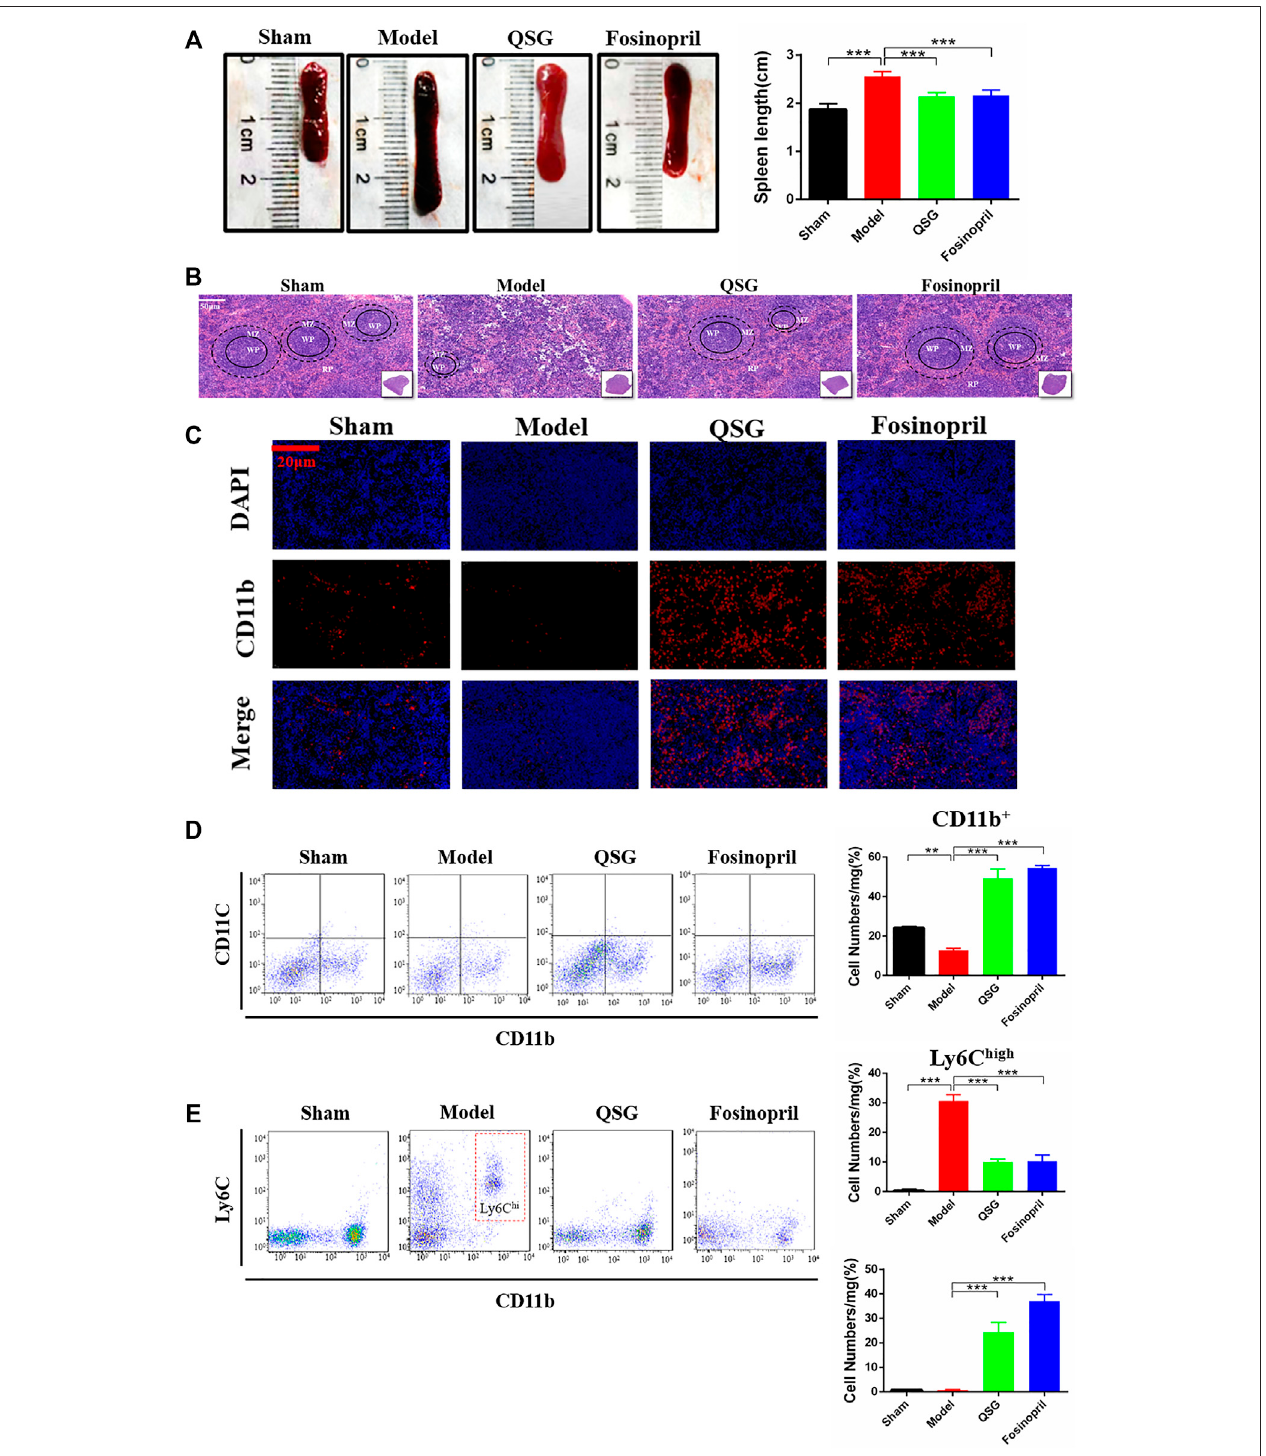
FIGURE 2 | QSG inhibited the pathological changes of the spleen and the release of splenic monocytes in HF mice. (A) Representative photomicrograph of the spleen morphology and histogram of length statistics. N = 6 per group. (B) Representative spleen images of HE staining in each group. Scale bar = 50 µm. (C) Representative spleen tissue images of CD11b immuno fl uorescence from different groups. Scale bar = 20 µm. (D) Flow cytometry for CD11b monocytes counts and statisticalanalysisinthespleen.N=3pergroup. (E) FlowcytometrytodetectthenumberofLy6C high andLy6C low monocytesinthespleenandstatisticalanalysis. N = 3 per group. ** p < 0.05, *** p < 0.001 vs. model group.